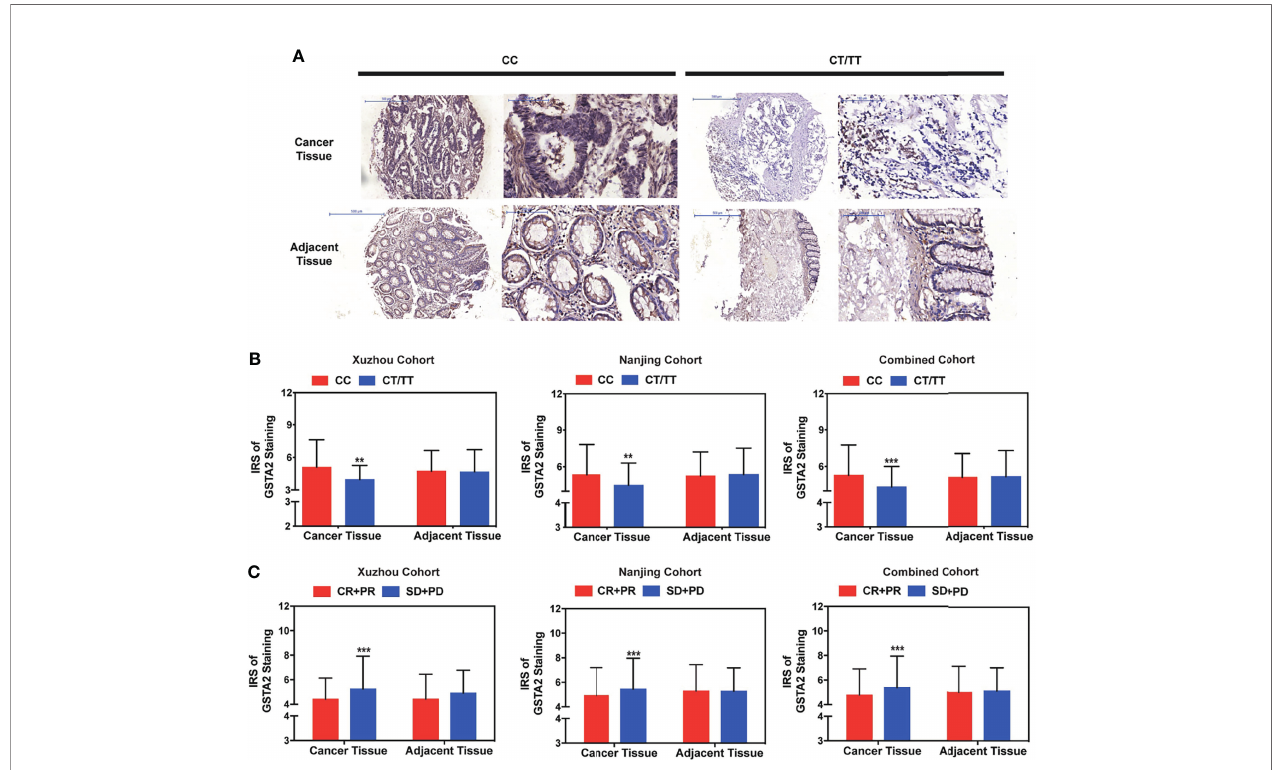
FIGURE 6 | High GSTA2 expression predicted poor clinical outcome in metastatic colorectal cancer treated with FOLFOX. (A) Immunohistochemical staining for GSTA2 in patients with colorectal cancer patients harboring different rs2278176 genotypes (representative IHC images were obtained at 100× and 400× magni fi cation). (B) The IRS of the expression of GSTA2 in patients with colorectal cancer harboring different rs2278176 genotypes ( n = 149, 312, and 461 in Xuzhou, Nanjing, and combined cohort, respectively, *** P < 0.001; two-sided t -tests; error bars: SD). (C) The IRS of GSTA2 expression in colorectal patients with different tumor response status. ( n = 149, 312, and 461 in Xuzhou, Nanjing, and combined cohort, respectively, *** P < 0.001; two-sided t -tests; error bars: SD). ** P <